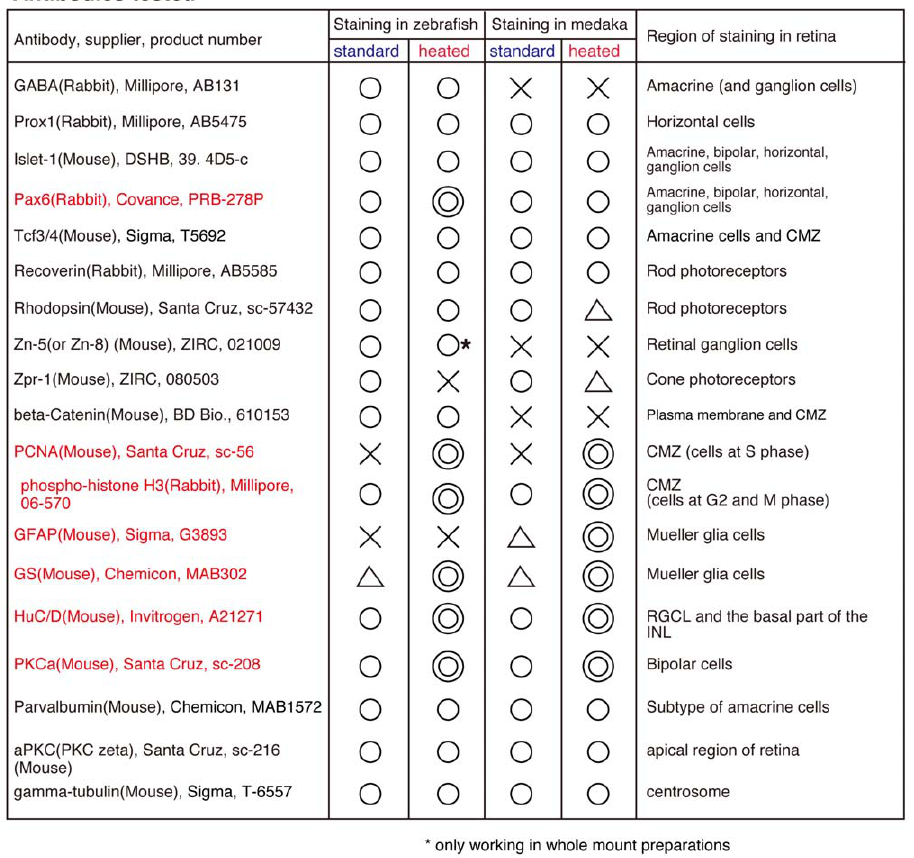
Figure 2. Antibody list tested in zebrafish and medaka with or without the heating method. The efficacy of immunostaining of cryosections based on the fluorescent intensity is indicated by double circled, circled, triangle, crossed. Double circled; working well. Circled; working. Triangle; weak. Crossed; not working. Most immunostainings with the heating method were comparable to those with the standard protocol except for the immunostaining of Zpr1, maybe due to the masking of the antigens by heating. Importantly, the heating method appreciably improved some immunostainings, which are important markers of neuronal and progenitor/stem cells. CMZ; ciliary marginal zone, RGCL; retinal ganglion cell layer, INL; inner nuclear layer. green (GFP) and red fluorescent protein (RFP) respectively (Figure 4A and B, [11]). Applying our new protocol to embryos carrying these transgenes facilitated the detection of GFP and RFP fluorescence at comparable intensity levels as in the untreated control embryos, both in cryosections and in whole mount preparations (Figure 4A and B, and Figure S3A and S3B). The fluorescence of the transgenic GFP itself was sufficient to compare its expression with either PCNA (whole mount) or HuC/D/pH 3 (cryosection) immunostaining in the transgenic line (Figure 4A and Figure S3A). Even the weaker Ath5::GAP43-RFP transgene was efficiently co-detected in immunostanings with the heating method. Using either anti-Zn5 or HuC/D antibody as a marker for RGC, Zn5- and HuC/D-immunostainings on the retinae of transgenic Ath5::GAP43-RFP embryos clearly showed the overlap and co-stain with the RFP-positive RGCs (or their progenitors near the CMZ, see brackets in Figure 4B) in whole mount preparations and cryosections, respectively (Figure 4B and Figure S3B, see brackets and arrowheads). The same results were also obtained in immunostainings of cryosections with the transgenic medaka line Rx2::histone H2B (H2B)-RFP, which labels retinal progenitor and Mueller glia and photoreceptor cells [11].